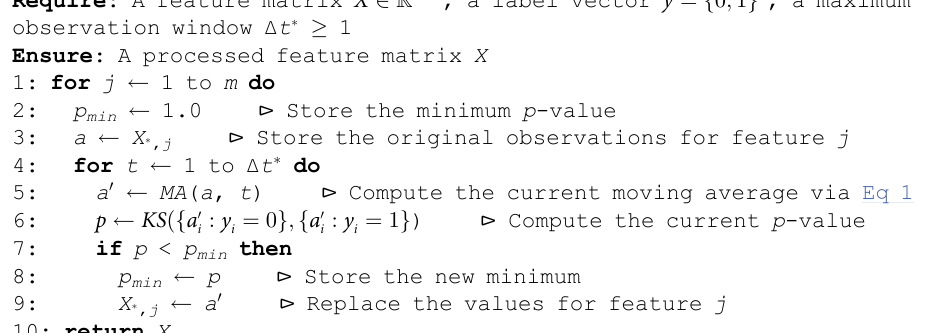
Algorithm 1 K-S Moving